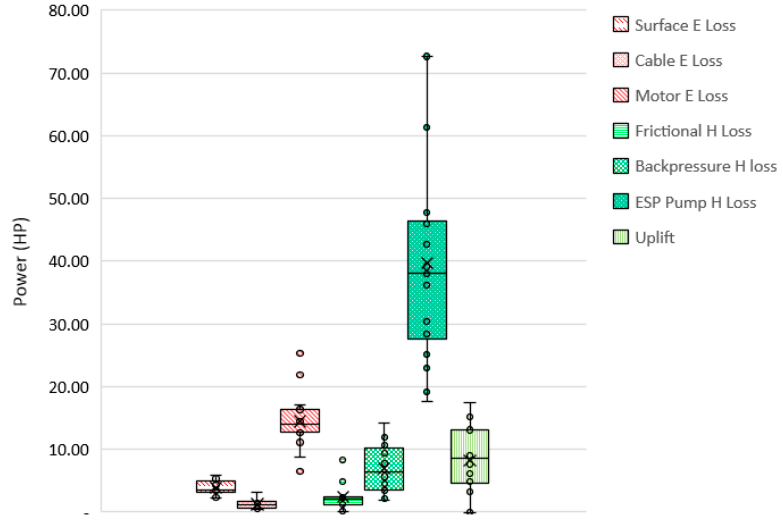
Figure 10. ESP Hydraulic, electrical, and overall losses.